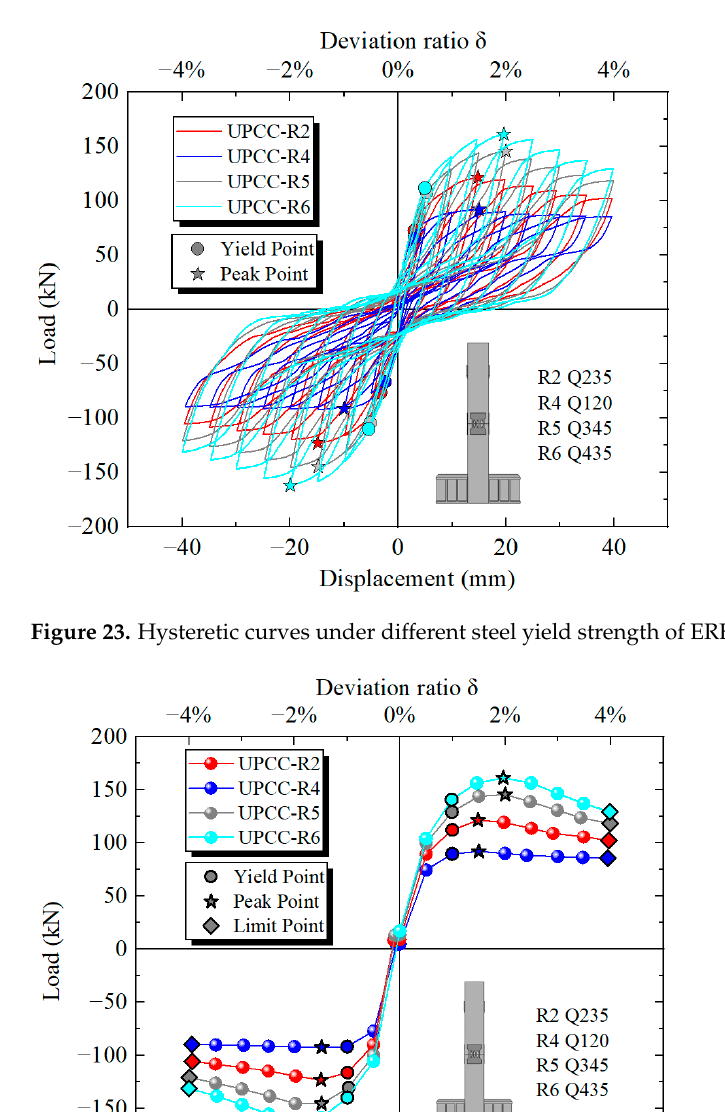
Table 10. The ductility coefficient of specimens under EREDL with different yield